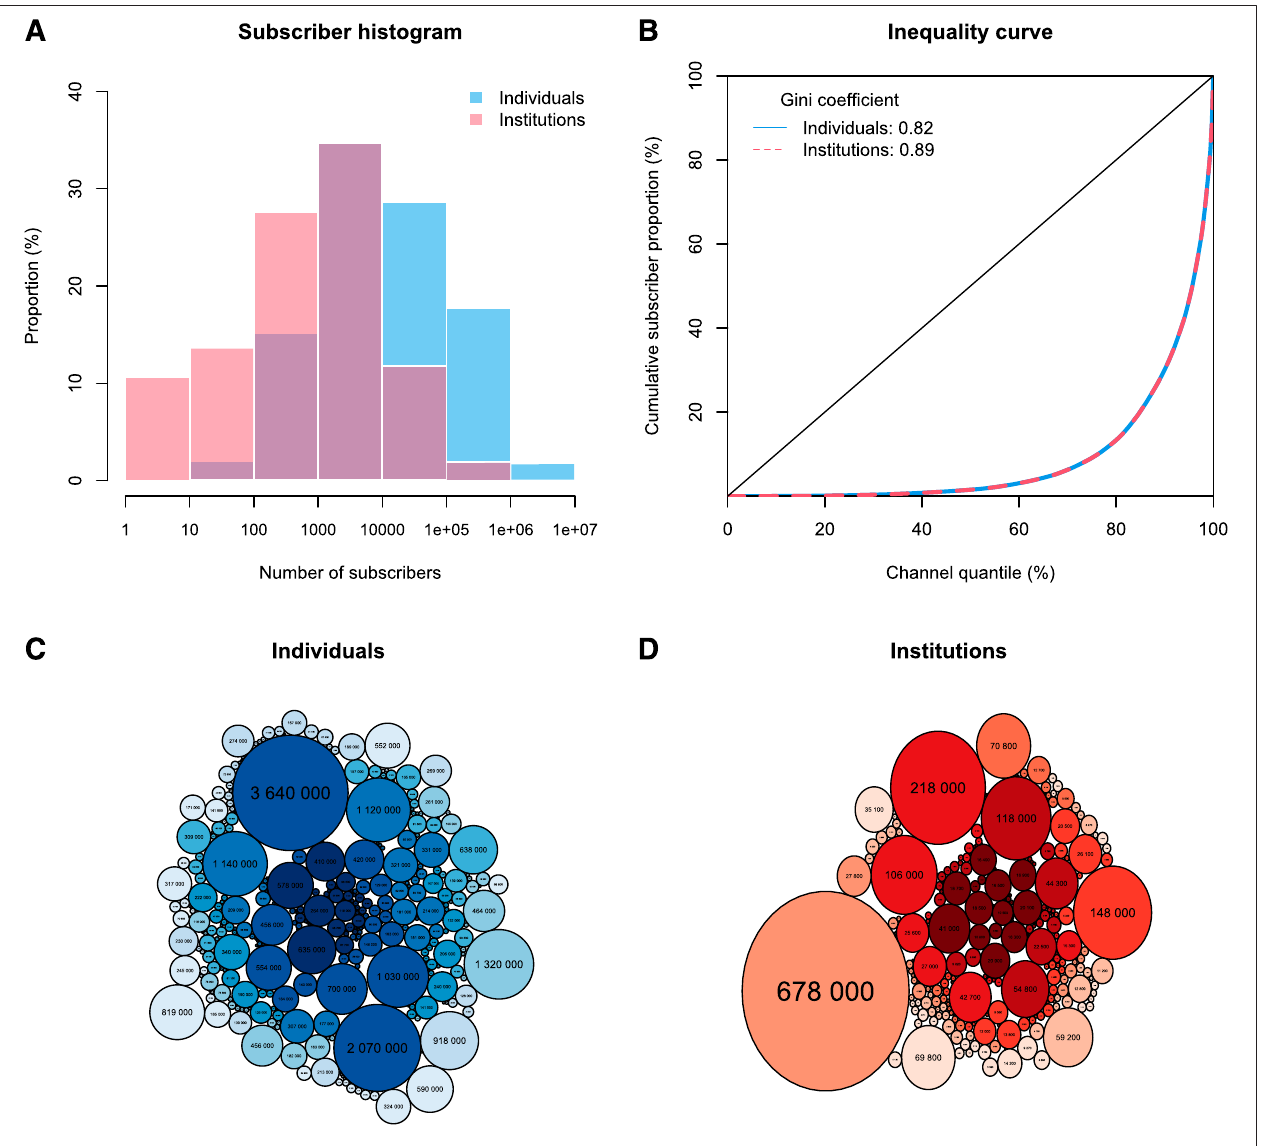
FIGURE 6 | Representations of the numbers of subscribers and subscribers inequalities. (A) Histogram of the number of subscribers (log10), (B) Lorenz curve describingtheinequalitiesinsubscribers. (C) and (D) Circlerepresentationofthevariationinthenumberofsubscribersamongchannels.Circlesizeisproportionaltothe number of